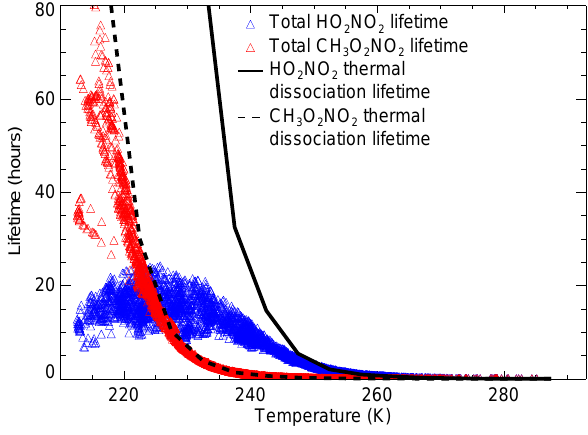
Fig. 8. Temperature dependence of CH 3 O 2 NO 2 and HO 2 NO 2 life- times for conditions sampled during ARCTAS. Symbols represent total lifetimes and solid lines are 5K binned thermal lifetimes. IR photolysis for HO 2 NO 2 is estimated as 1 × 10 − 5 s − 1 ( ∼